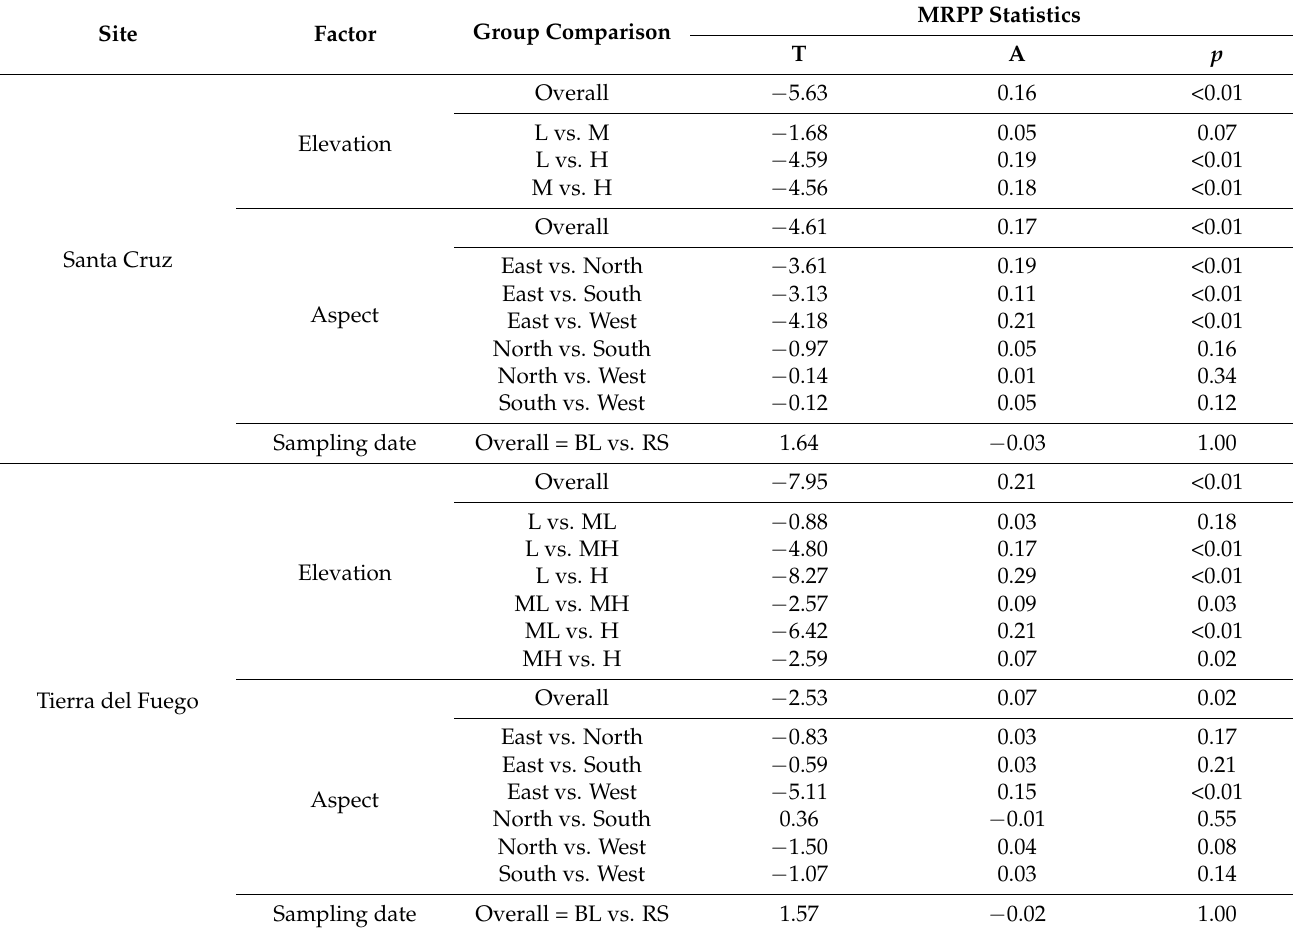
Table 3. Multi-response permutation procedure (MRPP) results comparing differences in the composition of alpine vascular plants in South Patagonia mountain sites, immersed in grassland (Santa Cruz) or forest (Tierra del Fuego) landscapes, according to groups defined by elevation (L = low, M = medium, ML = medium-low, MH = medium-high, H = high), cardinal aspect (north, east, south, west), and sampling date (BL = baseline, RS =